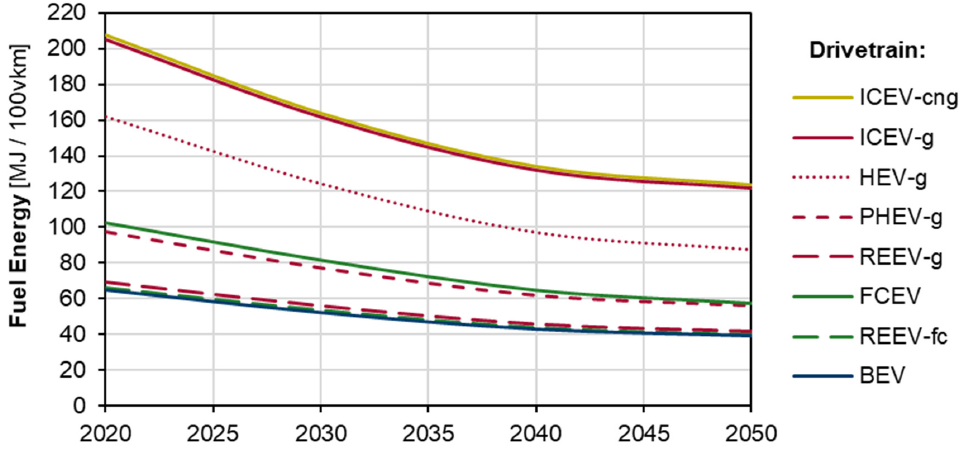
Figure 14. Energy demand for different drivetrain medium cars through 2050. For PHEV and REEV, fuel and electricity demand are summed up according to the respective driving shares.